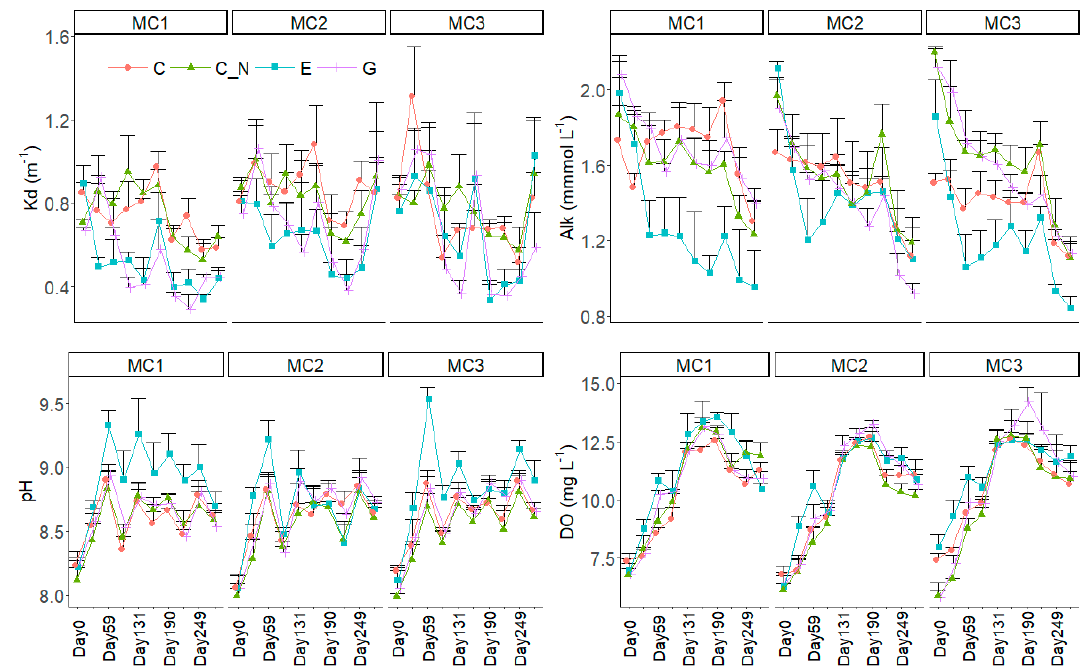
Figure 2. Changes in physico-chemical parameters (mean + SD) including light attenuation coefficient (Kd), alkalinity (Alk), pH and dissolved oxygen (DO) during the experiment for three macrophyte community treatments (MC1, MC2 and MC3) and the four extreme precipitation treatments (EP: C, C_N, E and G). For clarity, SD values are only shown in one direction. Table 2. Statistical summary of two-way ANOVA on the e ff ects of the macrophyte community (MC: MC1, MC2 and MC3) and extreme precipitation (EP: C, C_N, E and G) on plant biomass and morphology at the end of the experiment. The post-hoc test was conducted by the Tukey